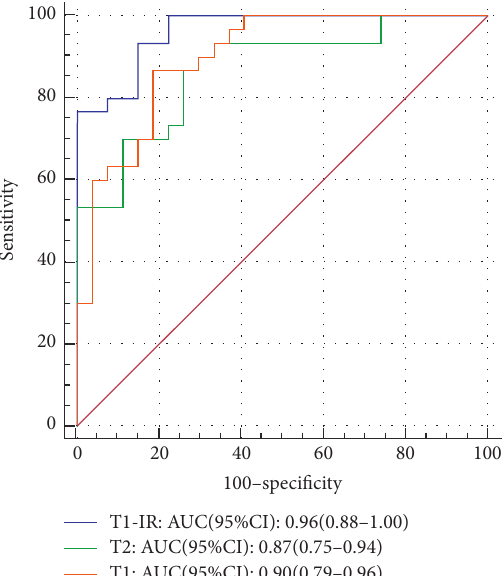
Figure 5: AUC of the final model of each sequence (T1-IR: out-of-phase T1W, T1: in-phase T1W, and T2 : T2W). Table 3: Mean value of specificity, sensitivity, and accuracy of 100-time cross-validation in each sequence. Group Specificity Sensitivity Accuracy Out-of-phase